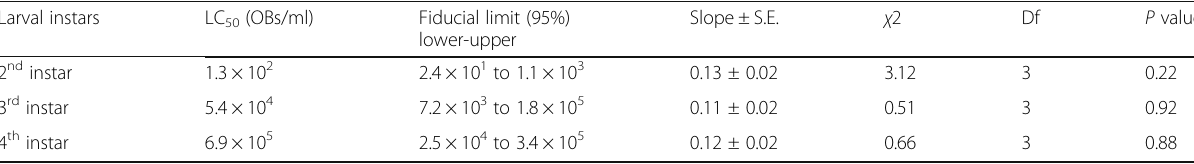
Table 1 LC 50 values of V- Splt NPV for different instar larvae of Spodoptera litura Larval instars LC 50 (OBs/ml) Fiducial limit (95%)